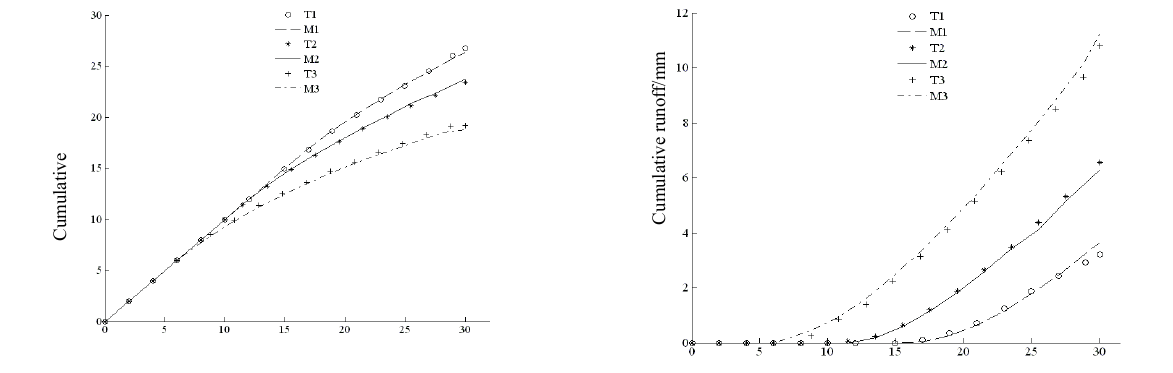
Fig. 2 The measured and simulated cumulative infiltration (a) and cumulative runoff (b), under the different initial soil moisture content in runoff